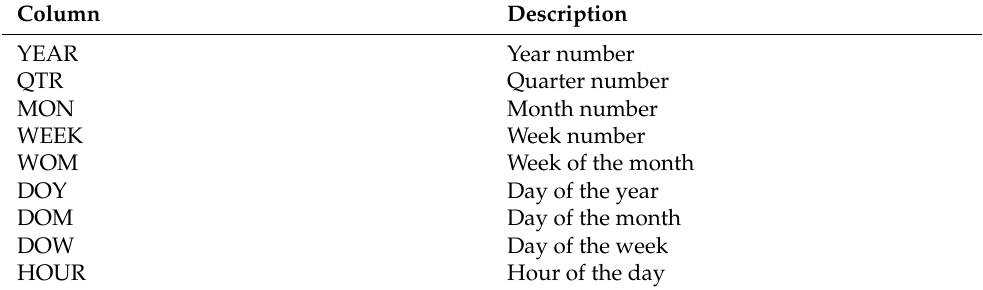
Table 2. Time feature vector.